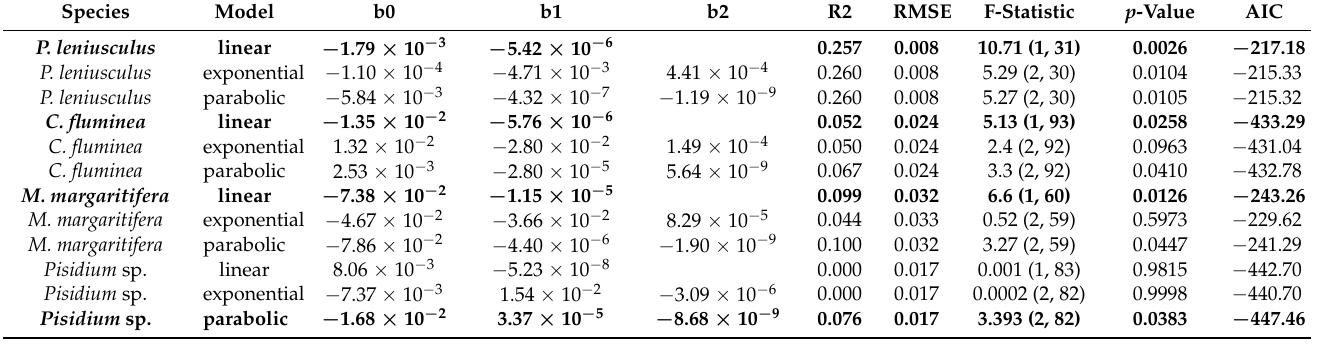
Table 3. Parameter estimates for tested models describing the relationship between net calcification rate and pCO 2 . Linear models took the form net calcification rate = b0 + b1 ∗ pCO 2 . Parabolic models took the form net calcification rate = b0 + b1 ∗ pCO 2 + b2 ∗ (pCO 2 ) 2 . Exponential models took the form net calcification rate = b0 + b1 ∗ e b2 ∗ pCO 2 . Bold rows indicate statistically significant model ( α = 0.05) with the lowest AIC value for a given species.